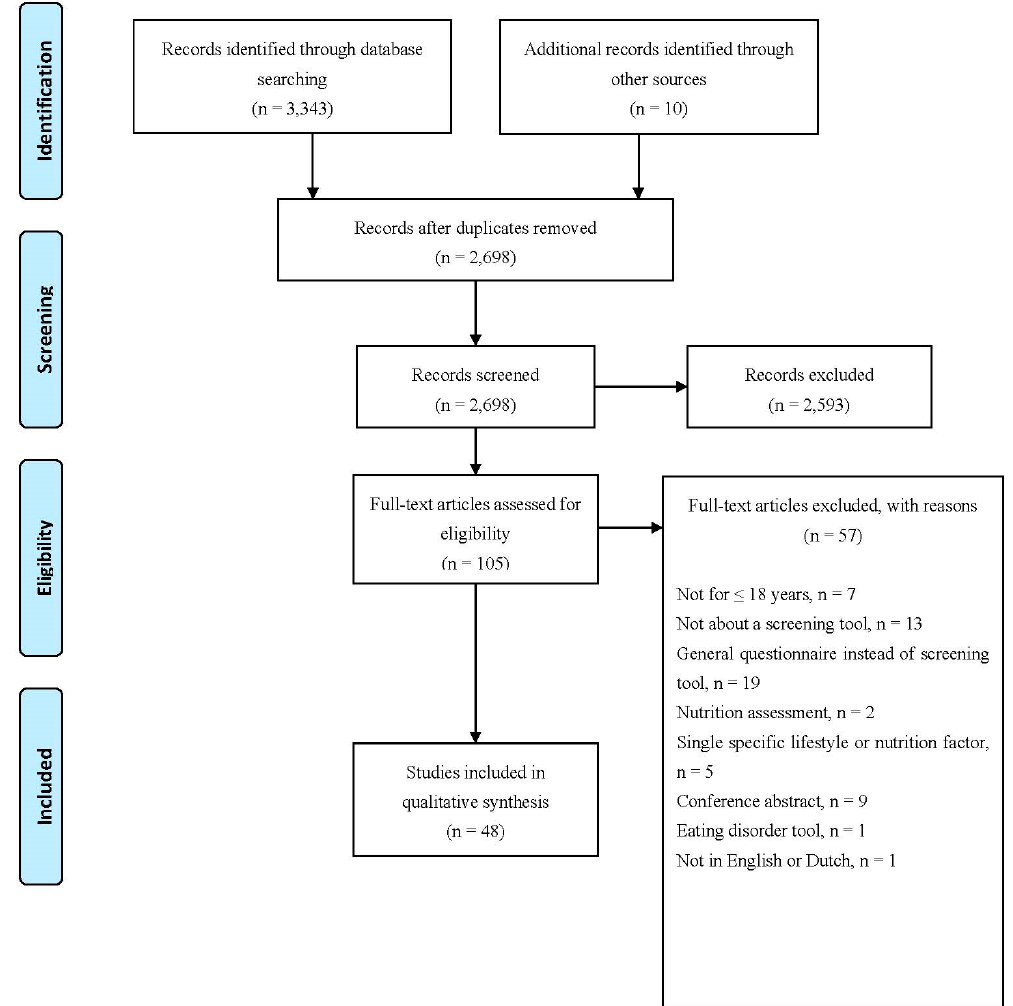
Figure 1. PRISMA flowchart of methodology.